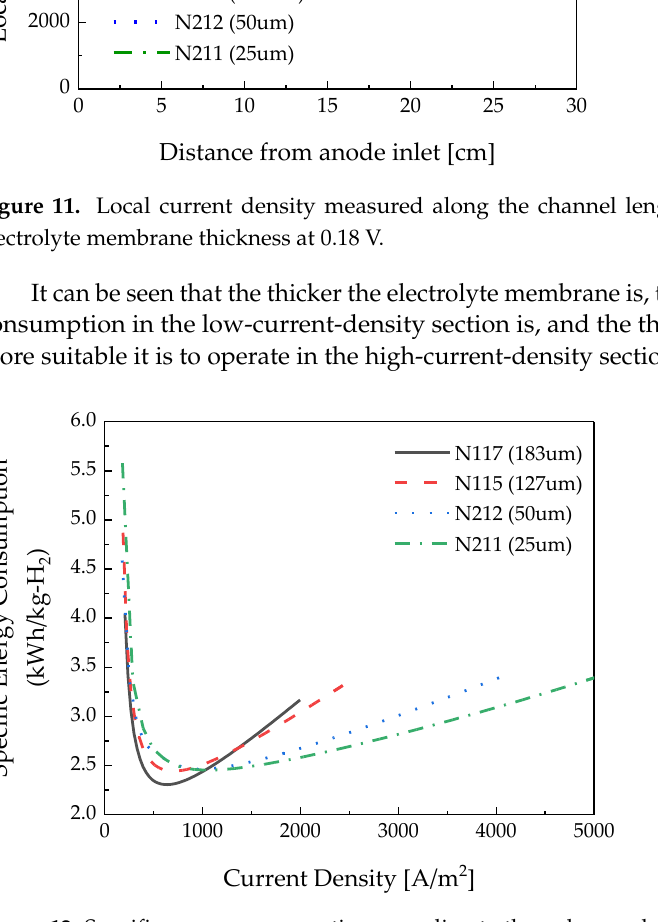
Figure 11. Local current density measured along the channel length according to the polymer elec- trolyte membrane thickness at 0.18 V.